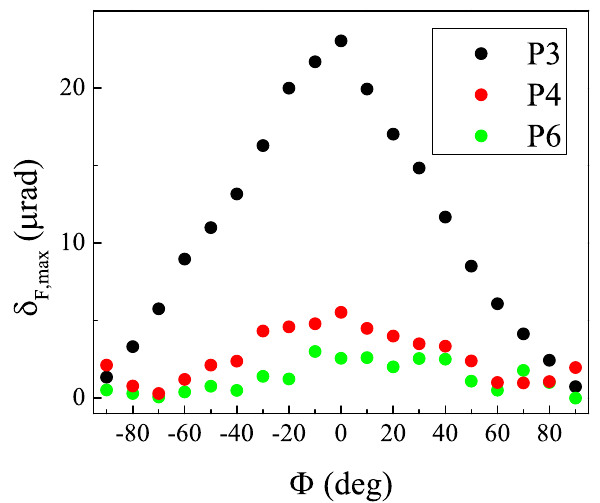
Figure 10. Angular dependence of δ F , max for P3, P4, and P6. δ F , max refers to Faraday rotation at saturation magnetic